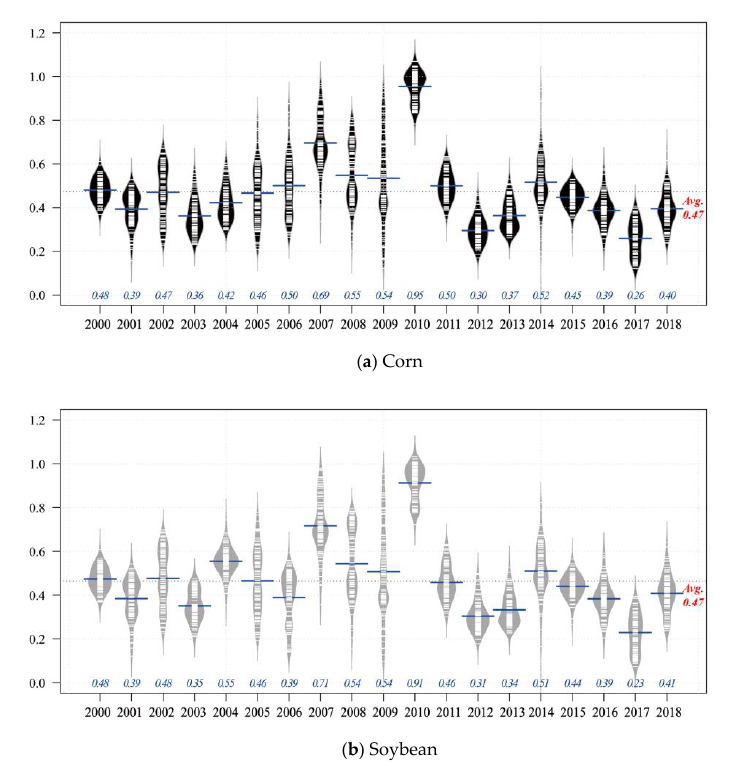
Figure 6. Temporal and regional changes in the REIC for corn and soybean in Iowa, USA.